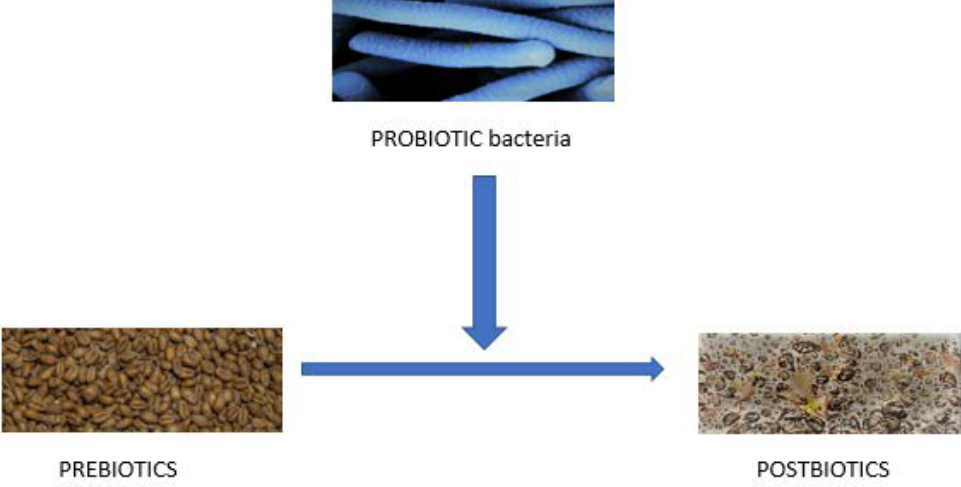
Figure 1. Relation between prebiotics (grains), probiotics bacteria, and postbiotics (selected fermented products and selected bacteria residue).